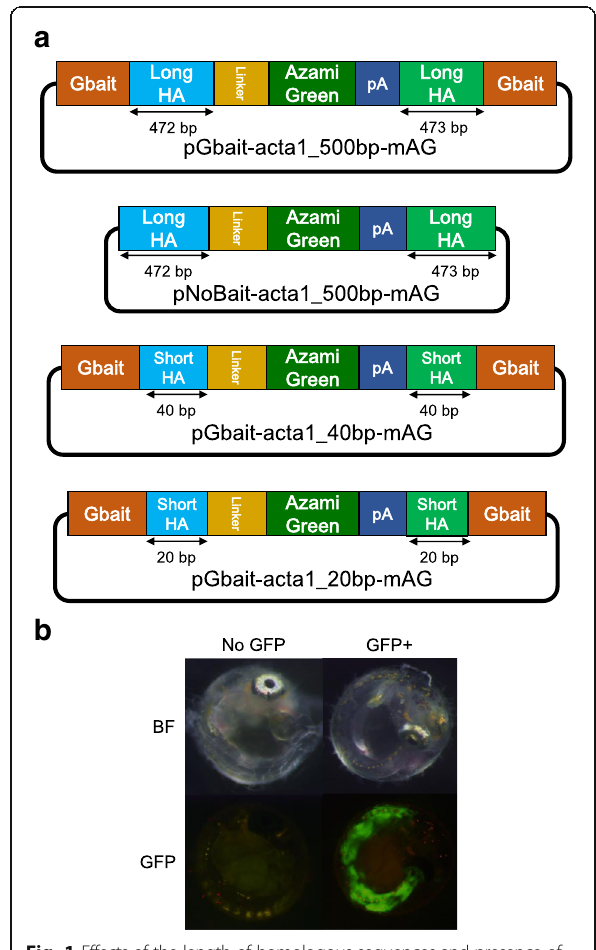
Fig. 1 Effects of the length of homologous sequences and presence of bait sequence on the efficiencies of targeted gene integration. (a) Schematics of each donor plasmid for evaluating the effects of homologous sequences and the bait sequence. The pGbait-acta1_500 bp-mAG plasmid contains long homology arms (Long HAs) and Gbait. The pNoBait-acta1_500 bp-mAG plasmid is the plasmid that removed the Gbait from pGbait-acta1_500 bp-mAG plasmid. The pGbait-acta1_40 bp-mAG plasmid contains 40 bp short homology arms (Short HAs) and Gbait. The pGbait-acta1_20 bp-mAG plasmid contains 20 bp short homology arms (Short HAs) and Gbait. (b) Embryos at 4 days post fertilization (dpf). Embryos injected with each plasmid, Cas9 RNA (100 ng/ μ l) with or without Gbait-sgRNA were categorized into the following two groups; “ No GFP ” for embryos without green fluorescence and “ GFP+ ” for embryos with fluorescence in the skeletal muscle, respectively. BF: bright field, GFP: GFP fluorescent